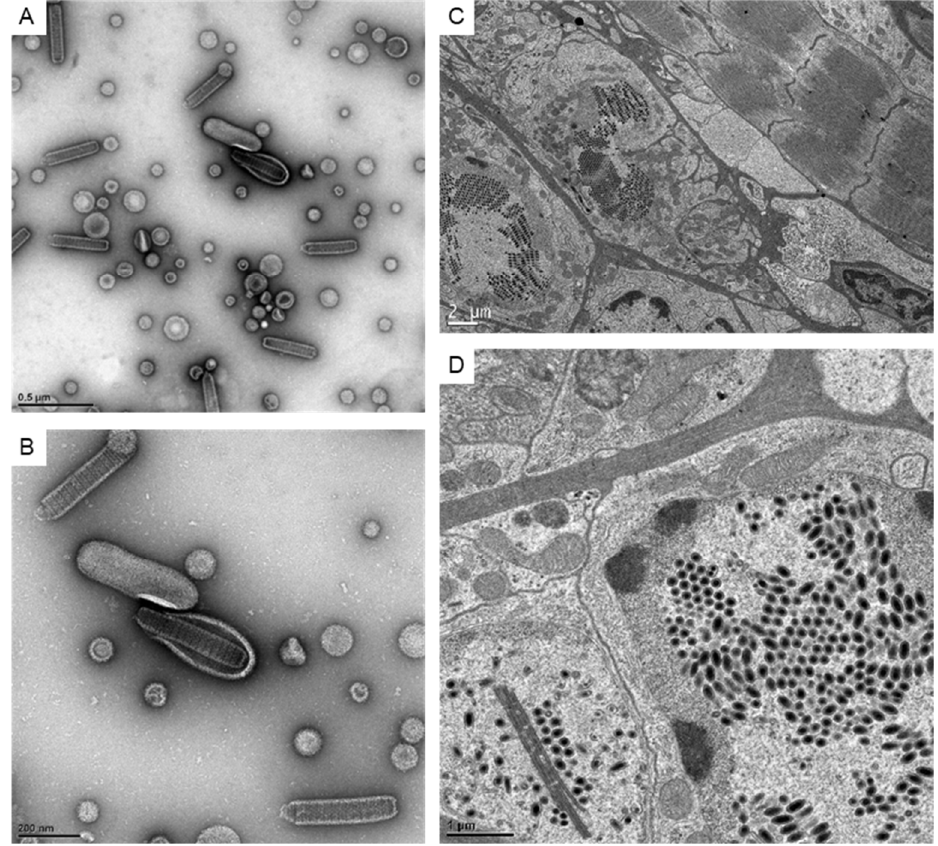
Figure 1. The images of WSSV particles and associated structures under TEM. ( A , B ): The represented images showing the negative stain of virus particles for crayfish inoculations. ( C ): The TEM images showing the WSSV-infected intestine tissues at low magnification. ( D ): The TEM image shows the virus particles and virus-associated structures in the nucleus.